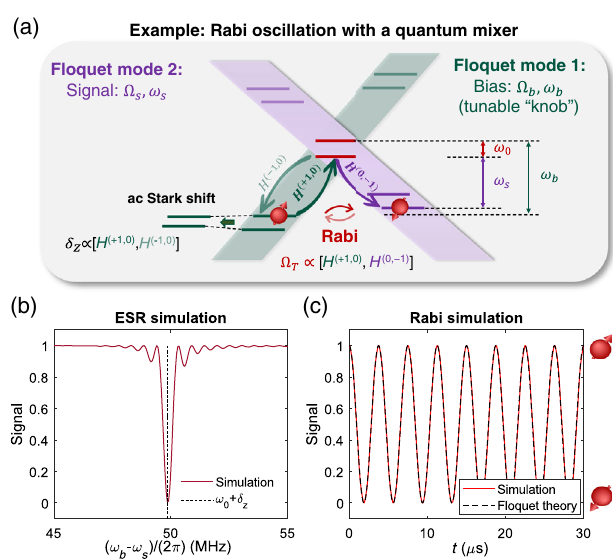
FIG. 2. Characterization of the effective Hamiltonian [Eq. (12)] predicted by Floquet theory, for a qubit of energy ω 2 π Þ 50 MHz and a signal field with frequency ω 0 ¼ ð ð 2 π Þ 375 MHz and amplitude Ω sz ¼ ð 2 π Þ 10 MHz. To achieve quantum frequency mixing, we apply a bias field with Ω b ¼ Ω sz . (a) Schematic showing the Rabi transition and the ac Stark shift mediated by the virtual Floquet states. (b) Qubit population in the j 0 i state at a fixed time t ¼ 1 . 875 μ s as a function of the bias field frequency. Similar to an electron spin resonance (ESR) experi- ment, we observe a resonance at ω b − ω s ¼ ω 0 þ δ z (marked by a dashed line). Note that the ac Stark shift here is obtained with a more precise analysis in the rotating frame such that δ z = 2 ¼ Ω 2 = 4 ð ω − ω 0 b Þ (see Appendix B 1). (c) Population in j b function of time, at the resonance condition. Similar to a Rabi experiment, we observe oscillations with a rate set by Ω Tz